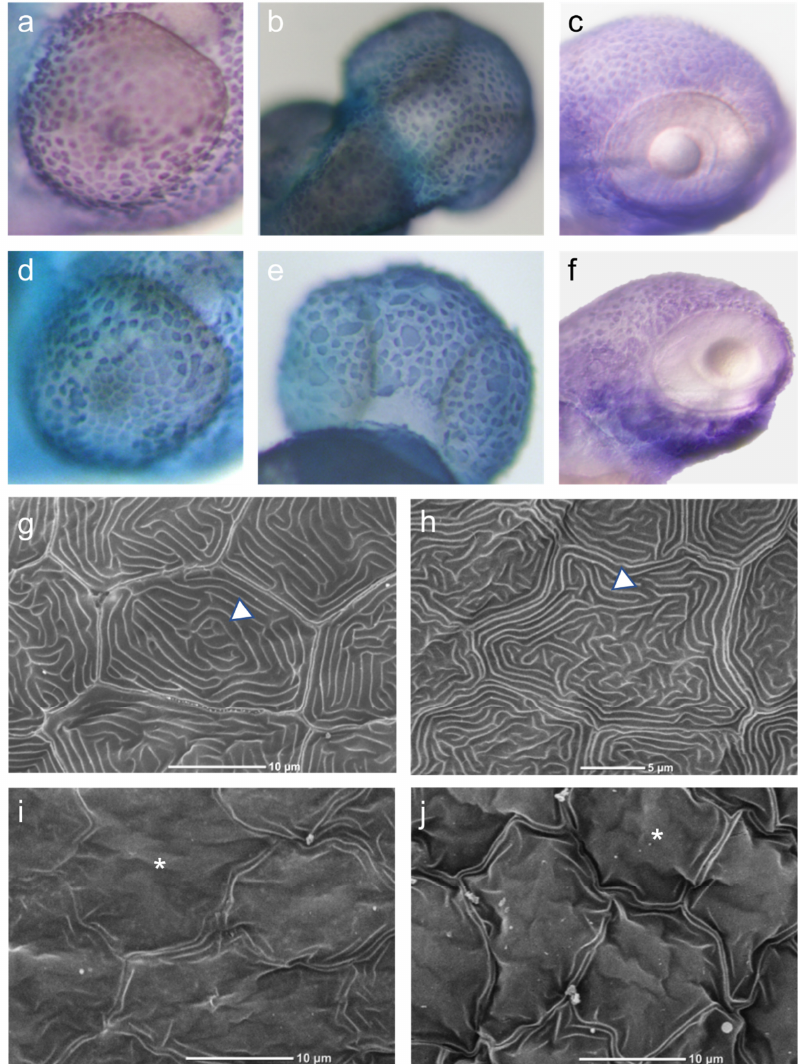
Figure 2. Keratinocyte morphology. Upper panel: Whole mount in situ hybridization with a probe recognizing cytokeratin1 mRNA (dark stain) at 2 dpf ( a , c , d , f ) and 3 dpf ( b , e ) demonstrating the distribution and morphology of keratinocytes over the eye ( a , d ) and over the head ( b , c , e – f ) areas. Control larvae were injected with an empty plasmid ( b ) or gfp RNA ( a , c ), and compared to larvae injected with h CARD14 ( e ) or zfcard14 ( d , f ). Note in both regions the uneven distribution and size as well as cell cluster formation as a consequence of CARD14 overexpression as opposed to the even size and regular borders of control keratinocytes. Lower panel: Scanning electron microscopy of 2 dpf embryos. Uninjected ( g ) and gfp- RNA injected ( h ) embryos display a uniform and complete array of microridges (triangle), and smooth cell surface, while zfcard14 ( i ) and hCARD14 injected ( j ) embryos display uneven cell surface topography